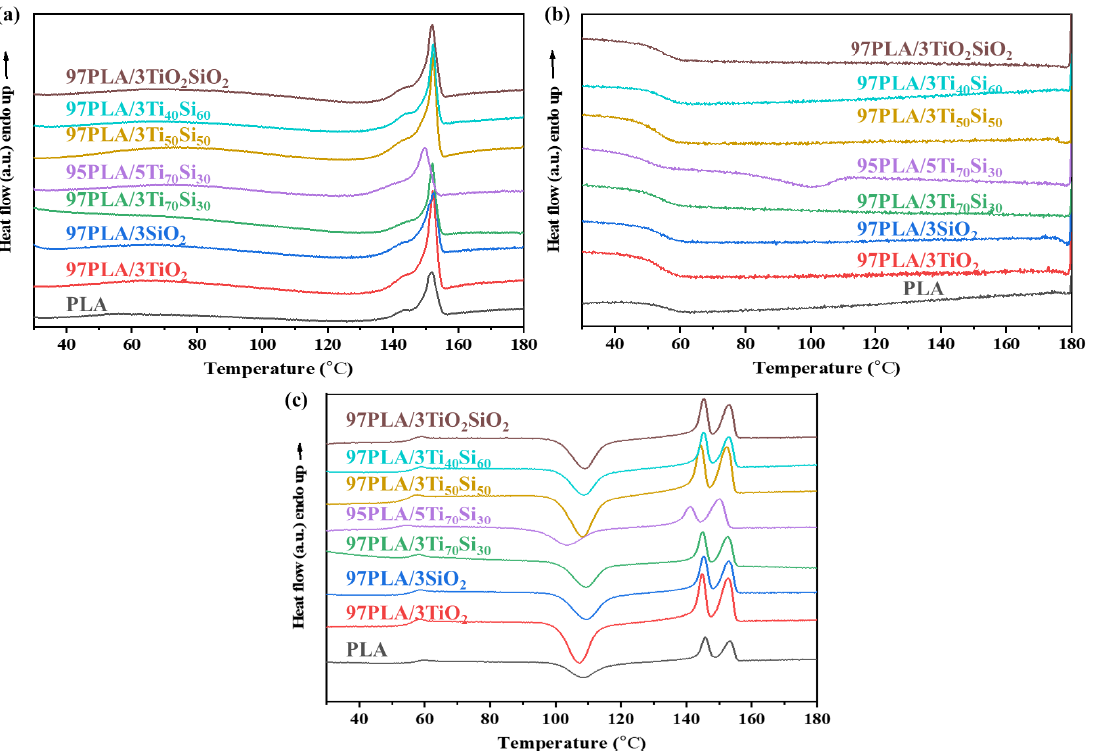
Figure 4. DSC thermogram of ( a ) first heating, heating rate 5 °C/min, ( b ) cooling, cooling rate 5 °C/min, ( c ) second heating, heating rate 5 °C/min of PLA, PLA/TiO 2 , PLA/SiO 2 , PLA/Ti x Si y , and PLA/TiO 2 SiO 2 composites